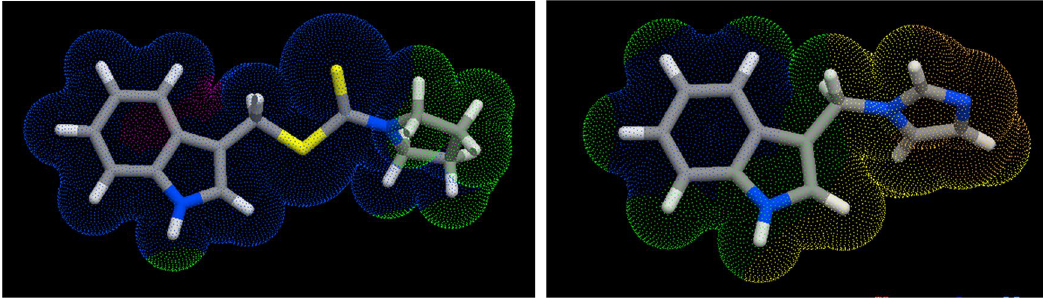
Figure 4. Molecular lipophilicity potentials of derivatives 12 (left) and 13 (right). Different colors indicate the hydrophobic (blue) and hydrophilic (yellow-orange-red) regions (https:// www. molin spira tion.